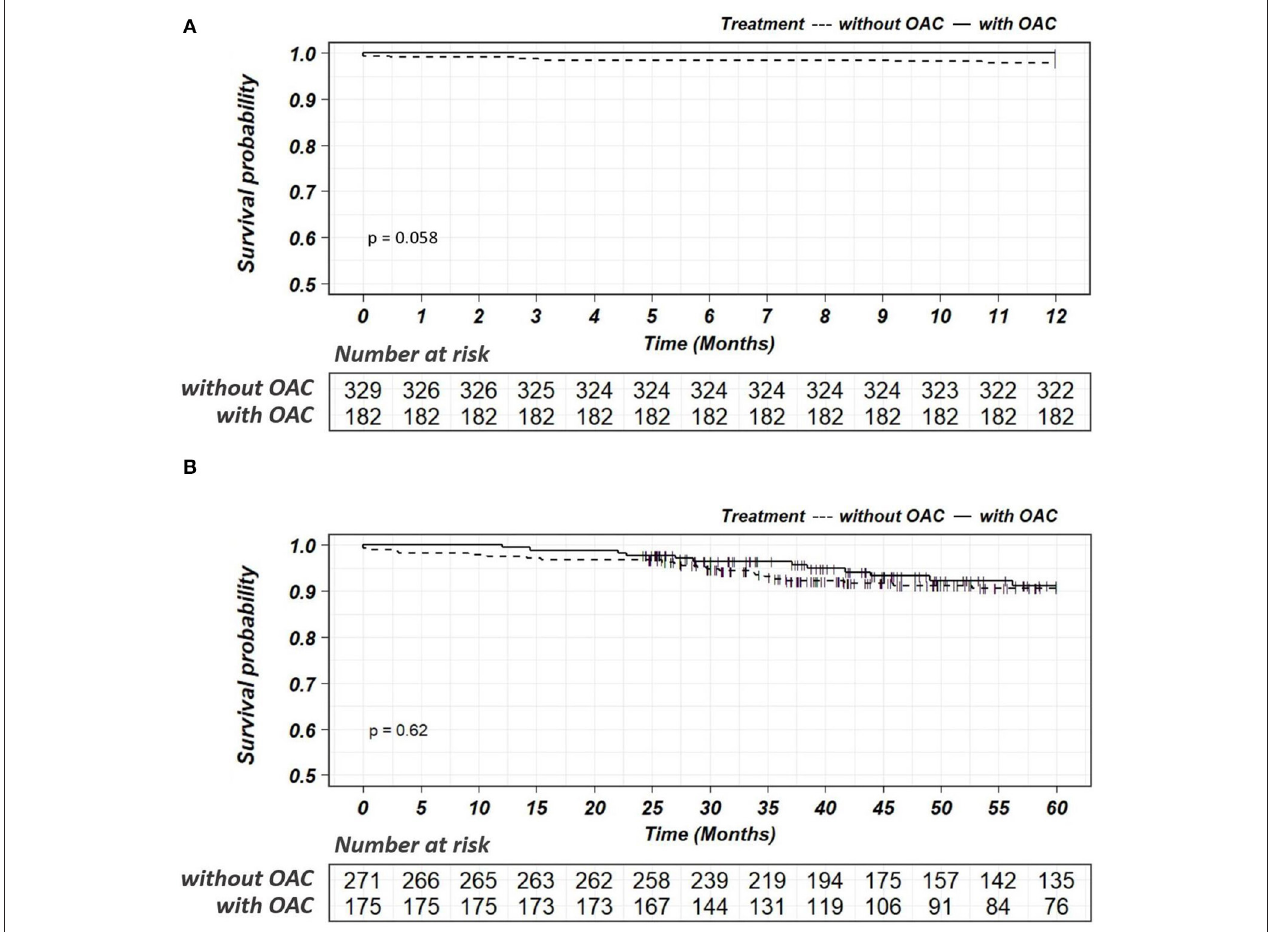
FIGURE 6 | Kaplan-Meier survival curves for the endpoints of bleedings within a follow-up of 1 year (A) or 5 years (B) in patients with or without OAC. OAC, oral anticoagulant.